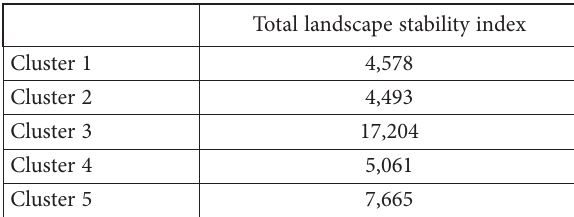
Table 4. Cluster’s stability index (source: by the